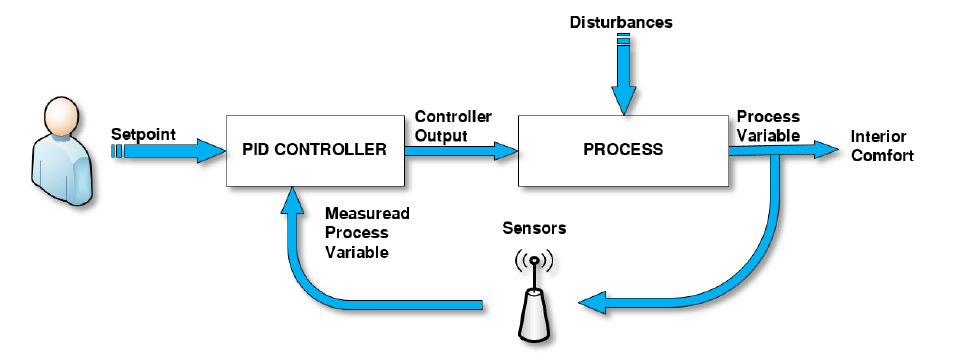
Figure 4. PID control in